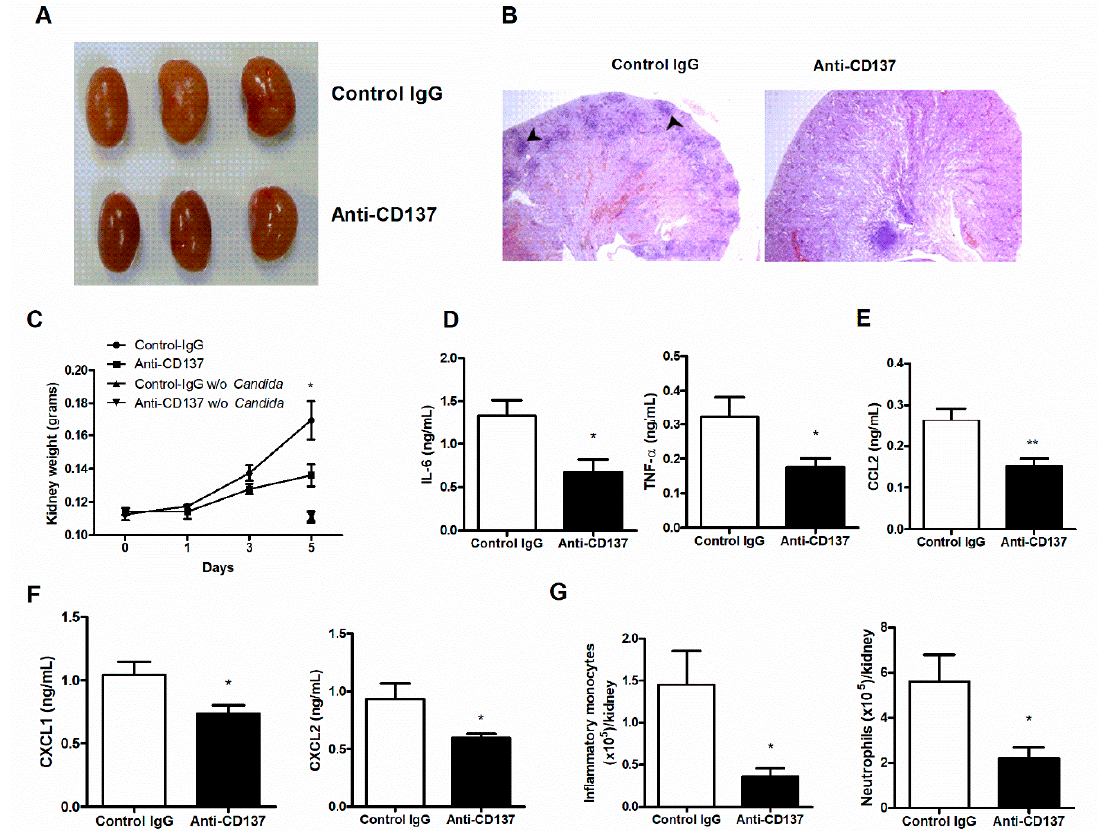
Figure 3. CD137 stimulation reduces renal inflammation after C. albicans infection. ( A – G ) C57BL/6 mice were injected intraperitoneally with 200 μ g of anti-CD137 or control rat IgG antibody 1 day before infection with 3 × 10 5 CFU of C. albicans . ( A ) Gross morphology. ( B ) Representative H&E staining of 3-d post-infection kidneys. Black arrowheads indicate representative nodules. Magnification: 40×. ( C ) Changes in kidney weight ( n = 6 mice per group). In some experiments, mice were injected with 200 μ g of control or anti-CD137 antibody without infection and kidney weight was measured 5 days after injection ( n = 3 mice per group). ( D – F ) Levels of IL-6 and TNF- α ( D ), CCL2 ( E ), and CXCL1 and CXCL2 ( F ) in kidney lysates at 3-d post-infection ( n = 5 mice per group). ( G ) Numbers of infiltrating inflammatory monocytes and